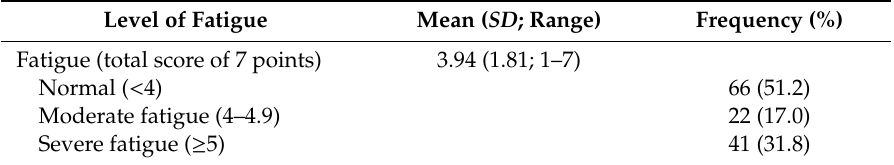
Table 1. Severity and prevalence of fatigue in older adults with diabetes ( N = 127).